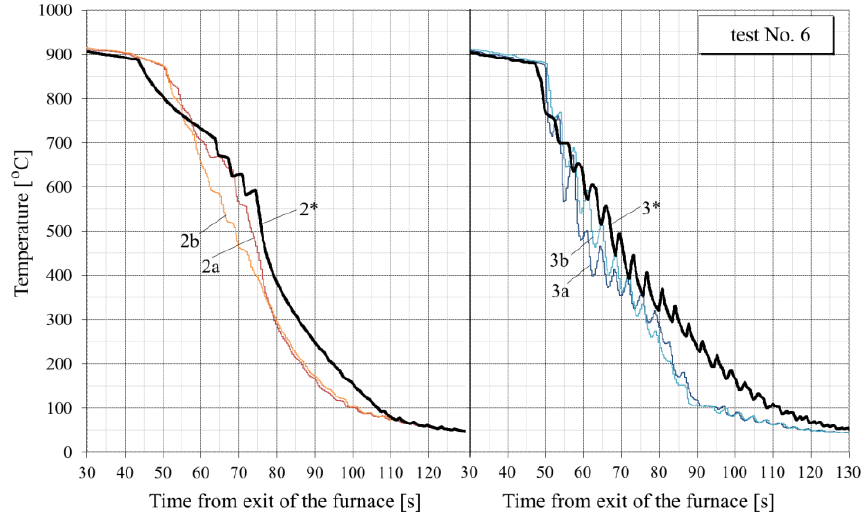
Figure A4. Graphs of cooling in test No. 6. Numbers without an asterisk denote experimental curves according to the thermocouple data: 2a—at the top in the middle of the width; 2b—at the top at the edge, 3a—at the bottom in the middle of the width; 3b—at the bottom at the edge. Numbers with one asterisk indicate calculated curves for the corresponding control points across the thickness of the plate: 2*—at a depth of 3 mm from the top surface; 3*—at a depth of 2.5 mm from the bottom